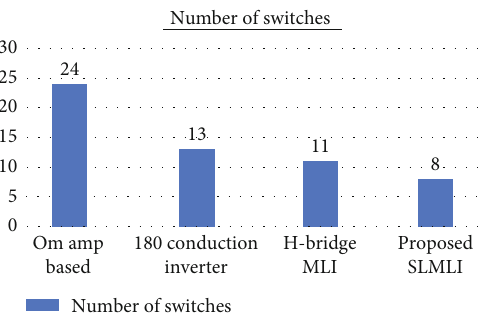
Figure 40: Comparison between numbers of switches.